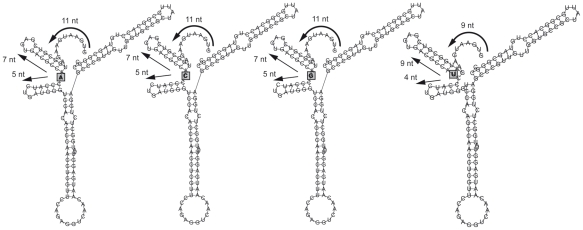
Predicted secondary structures in the 5′end of the ORF2 GII.4 RNA, with all possible nucleotides modeled at site 26 (boxed).Four nucleotides upstream of the first ATG were included, as these are conserved in the 5′end of ORF1 and ORF2 and likely to have a function in translation.